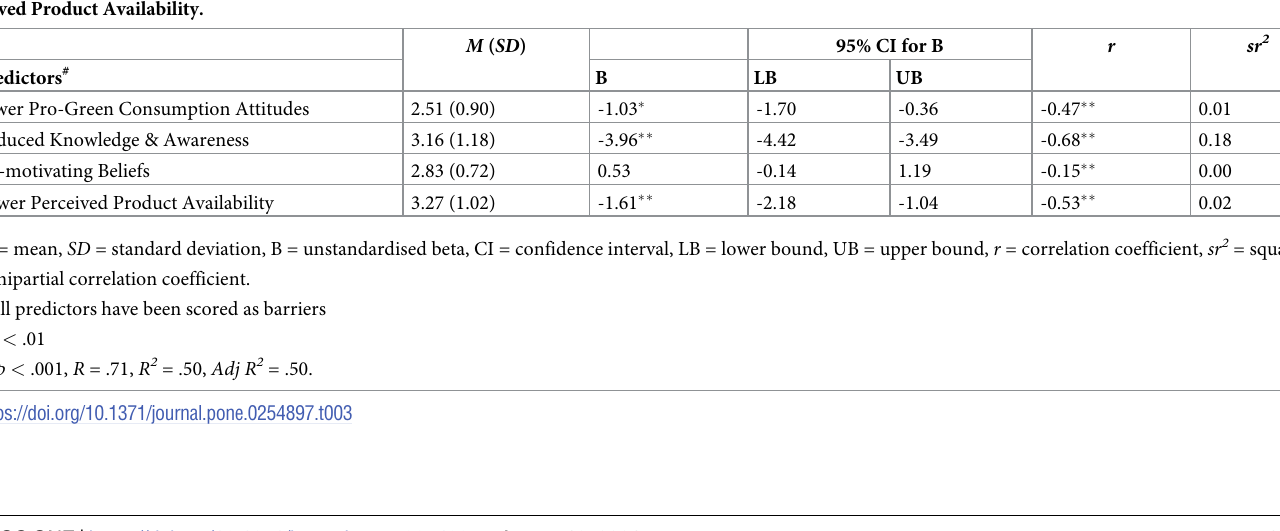
Table 3. Predicting purchasing of SPO products from the four COM-B factors of Pro-Green Consumption Attitudes, Knowledge, Demotivating Beliefs and Per- ceived Product Availability. M ( SD ) 95% CI for B r sr 2 Predictors # B UB Fewer Pro-Green Consumption Attitudes Reduced Knowledge & Awareness